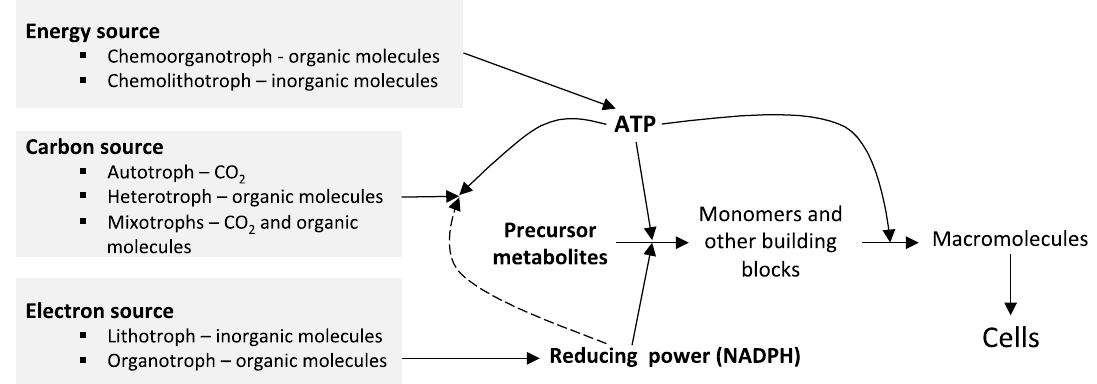
Figure 2. Microbial nutritional categories. Adapted from [18].